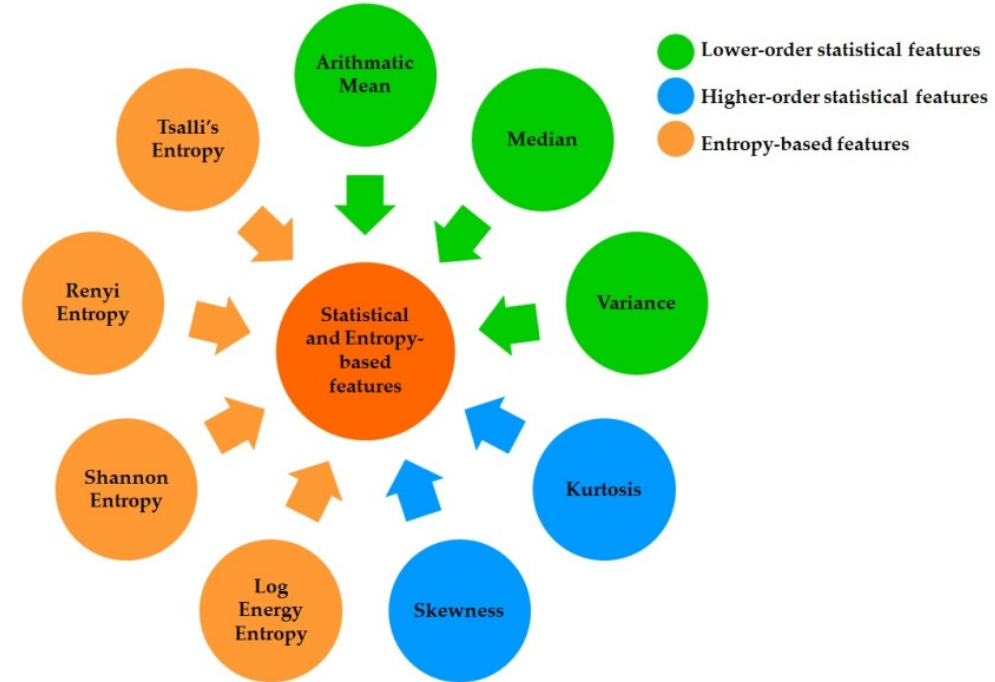
Figure 4. List of features used in the current study.